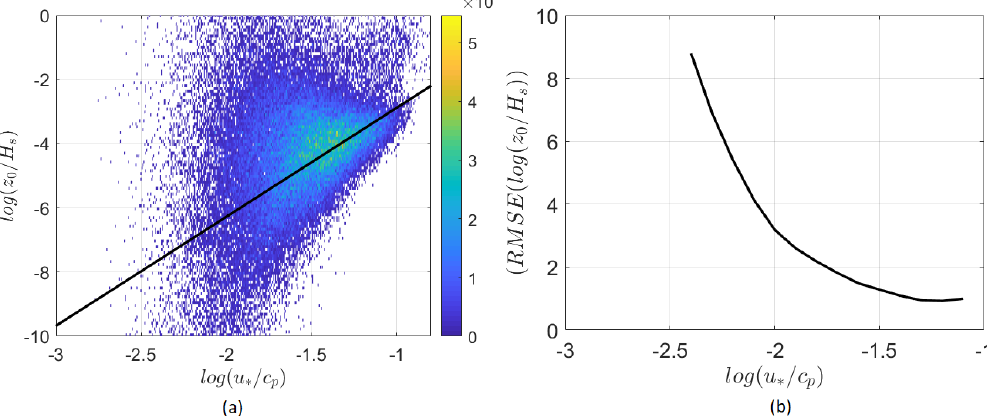
Figure 5. (a) The dimensionless roughness length, z 0 /H s , plotted against the inverse wave age parameter u ∗ /c p for the combined data set of 74108 points (ASIT and FINO1). The solid line represents the roughness length parameterization proposed by Drennan et al. (2003), Eq. (9).The color scale to the right indicates the probability of occurrence (%) of the measurement points. (b) The root mean square error of the measurement points compared to the parameterization proposed by Drennan et al. (2003).